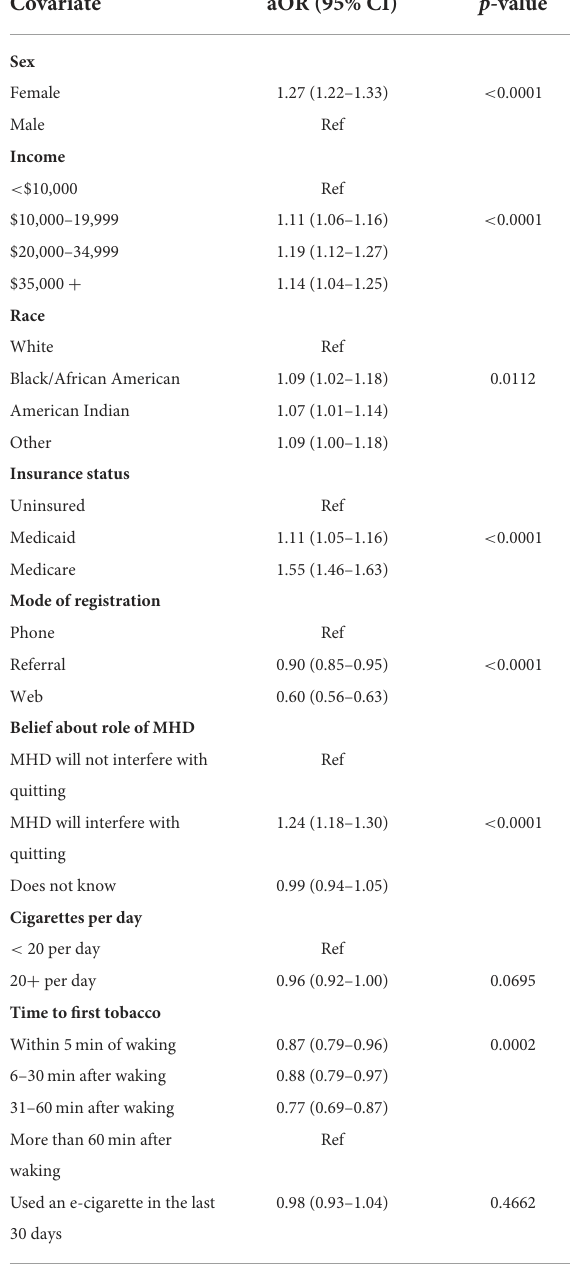
TABLE 3 Predictors of multiple call program enrollment among tobacco users reporting a mental health disorder (MHD) and eligible for the multiple call program [adjusted odds ratios (aOR) and 95% confidence interval